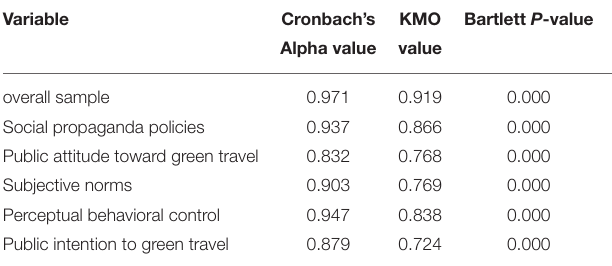
TABLE 3 | Reliability and validity test